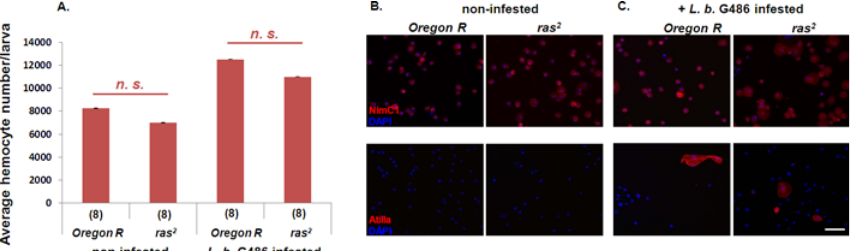
Fig 4. The number and morphology of circulating hemocytes in non-infested and immune induced Oregon-R and ras 2 larvae. (A) Total hemocyte number of non-infested and L . boulardi G486 infested (72h) larvae originated from Oregon-R or ras 2 mutant. n.s. means non-significant difference. (B) Hemocytes of non- infested or (C) L . boulardi G486 infested larvae (72h) were stained with plasmatocyte specific anti-NimC1 or with lamellocyte specific anti-Atilla antibody [38]. The scale bar indicates 20 μ